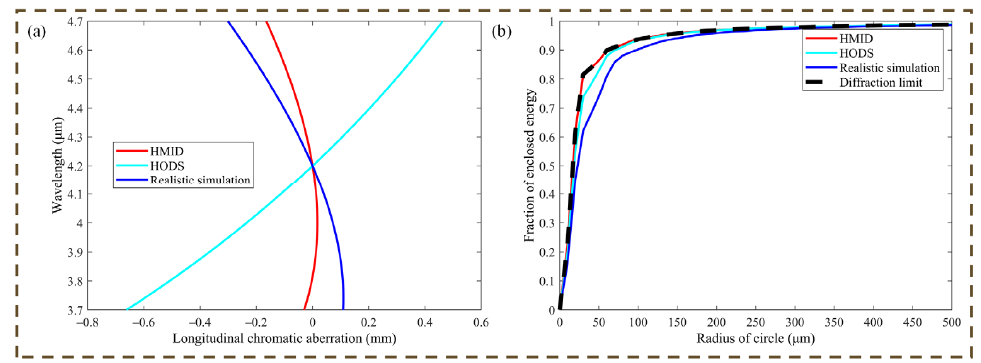
Figure 8. Realistic simulation parameters of HMID taking measurement inaccuracy into considera- tion. ( a ) LCA comparison against the design value, chromatic aberration is still in the small range; ( b ) Enclosed energy comparison against the design value.